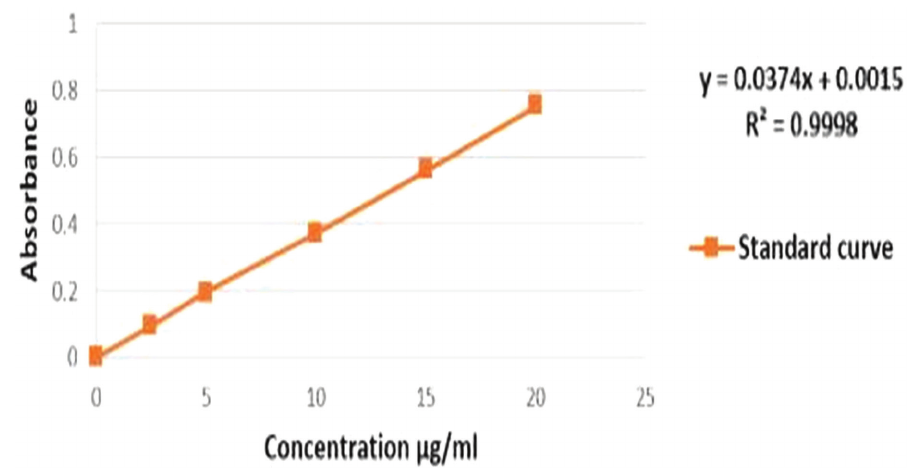
FIGURE 7 - Standard curve of cefuroxime axetil in phosphate buffer (pH 6.8). TABLE IV – Standard Calibration curve of cefuroxime axetil Concentration (μg/mL)